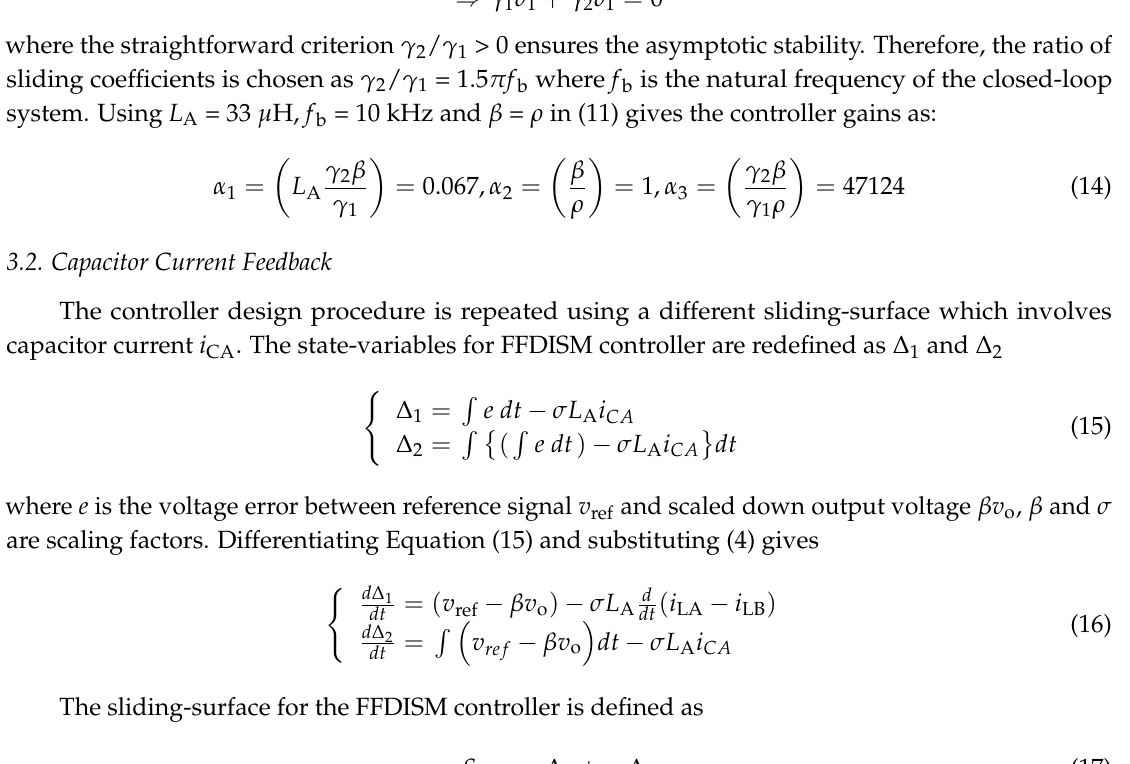
Table 1. Parameters of GaN class-D amplifier with fourth-order filter.